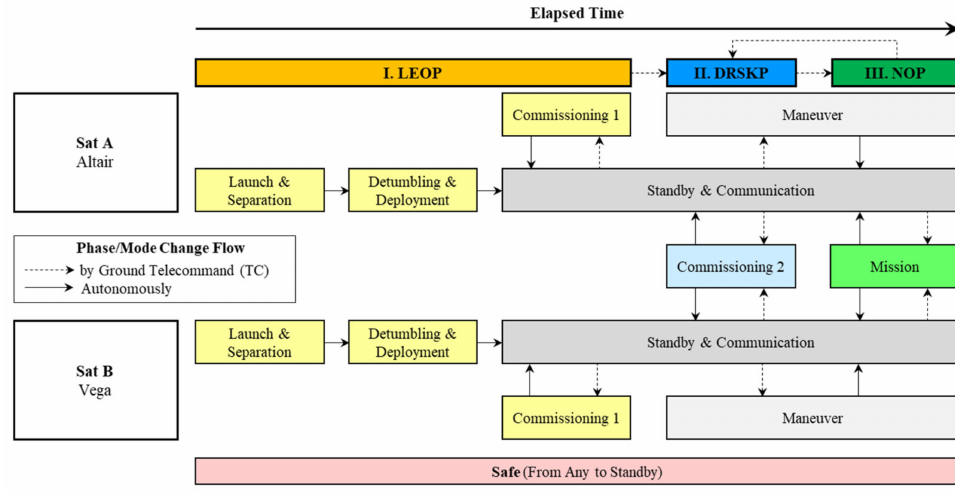
Figure 4. Operations mode flows